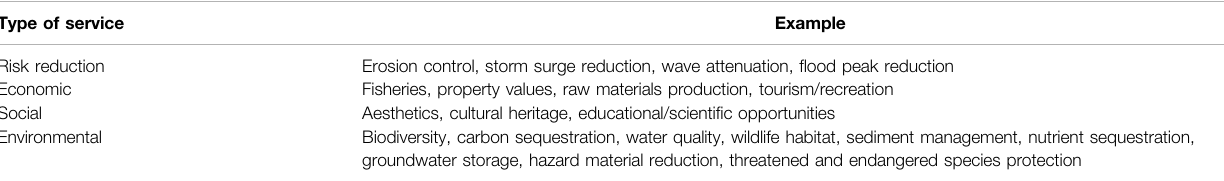
TABLE 2 | Potential services provided by NNBF (Bridges et al.,